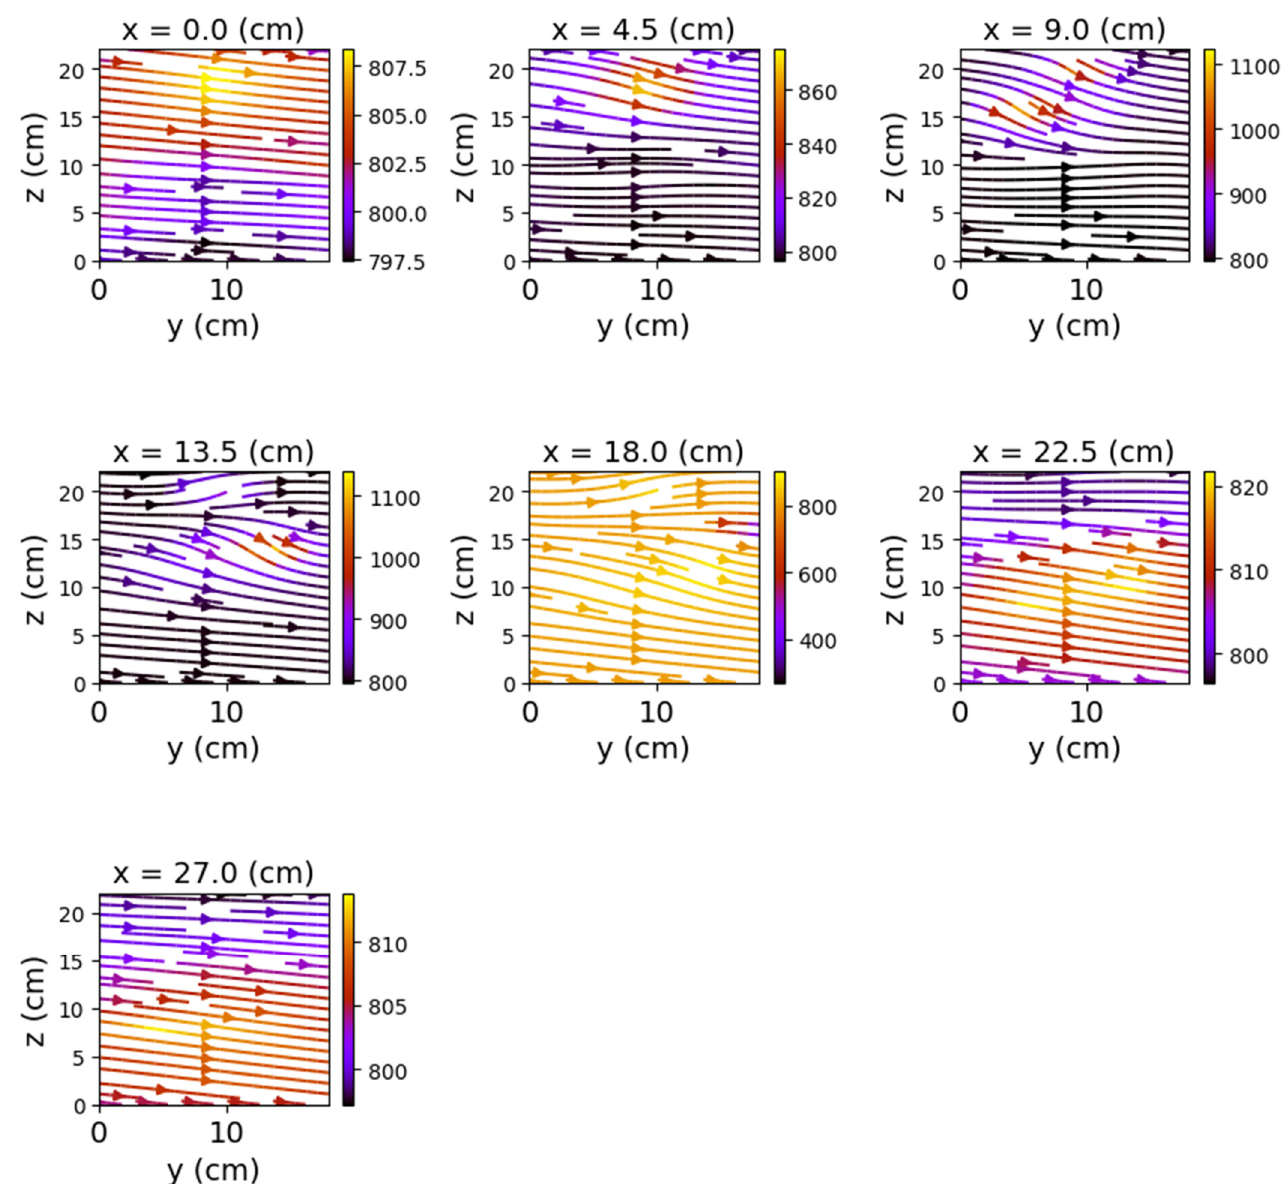
Figure 18. Field lines for y O z plane—relay with coil 2–4 powered.